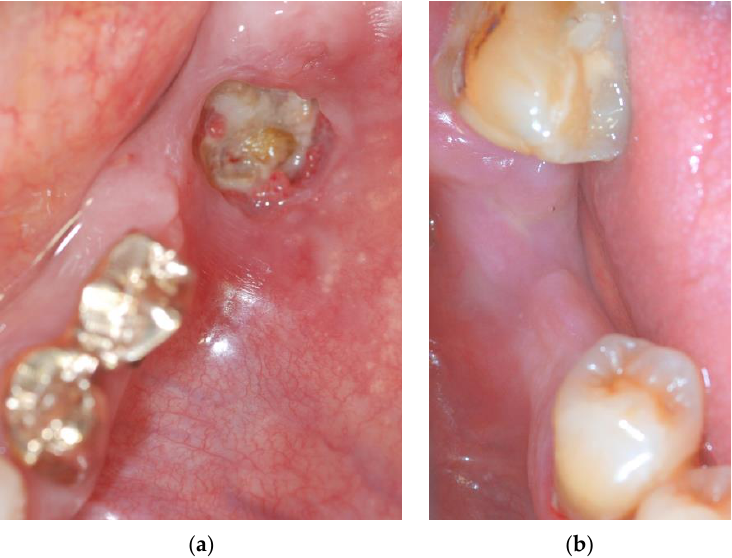
Figure 1. The exposed necrotic bone in the left lower edentulous first molar region before the surgery ( a ); the region affected by medication-related osteonecrosis of the jaws (MRONJ) on the right side before the surgery ( b ).